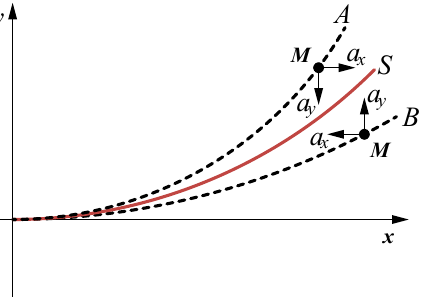
Figure 2. The acceleration of the mass point generated by the inertia